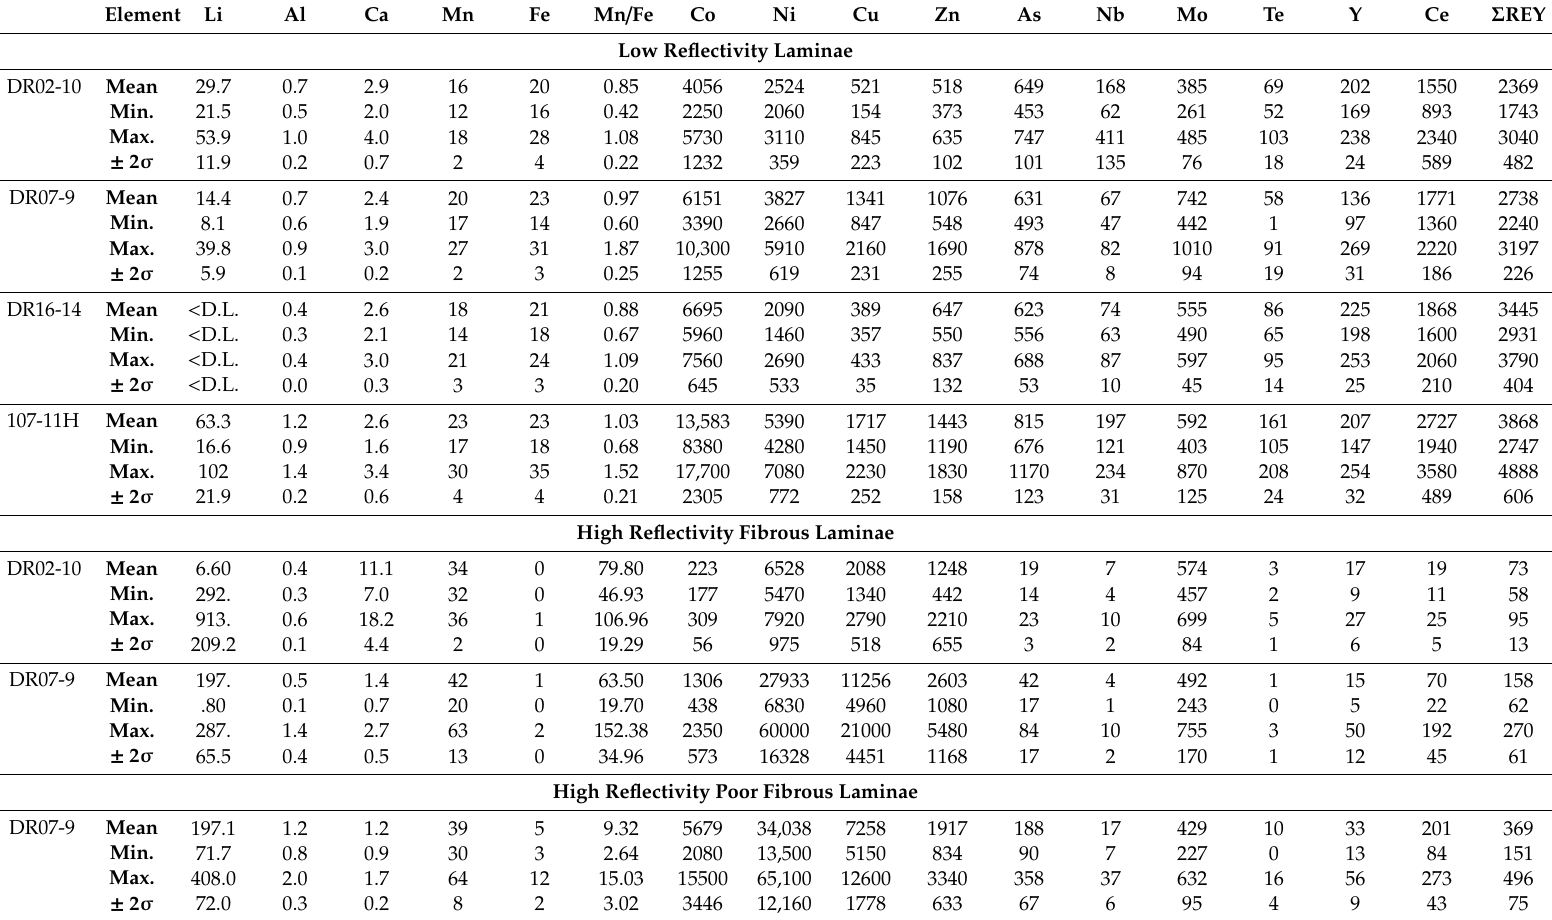
Table 5. LA-ICP-MS data obtained in the di ff erent laminae analyzed and divided by genetic process type. Values are expressed in µ g / g for all elements but majors (Al, Ca, Mn and Fe) expressed in wt. %. < D.L. below detection